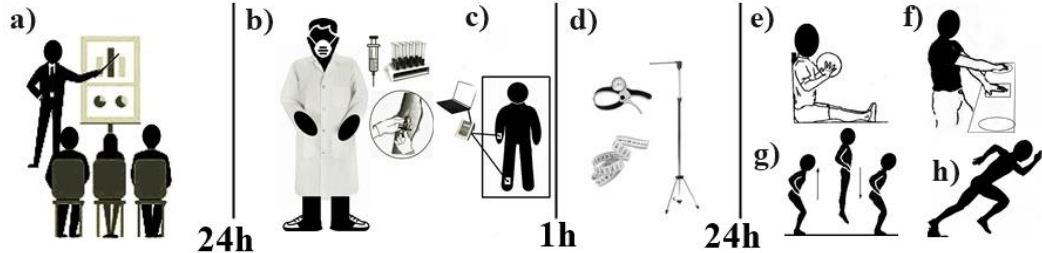
Figure 1. Study design. a = Study information for volunteers and their respective guardians. b = Biochemical tests. c = Body composition test. d = Collecting anthropometric measurements. e = Upper limb power test. f = Upper limb speed test. g = Lower limb power test. h = Body speed with change of direction